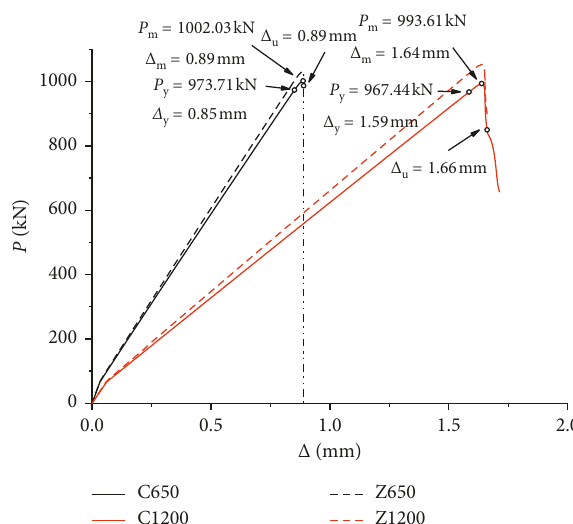
Figure 13: Models information.